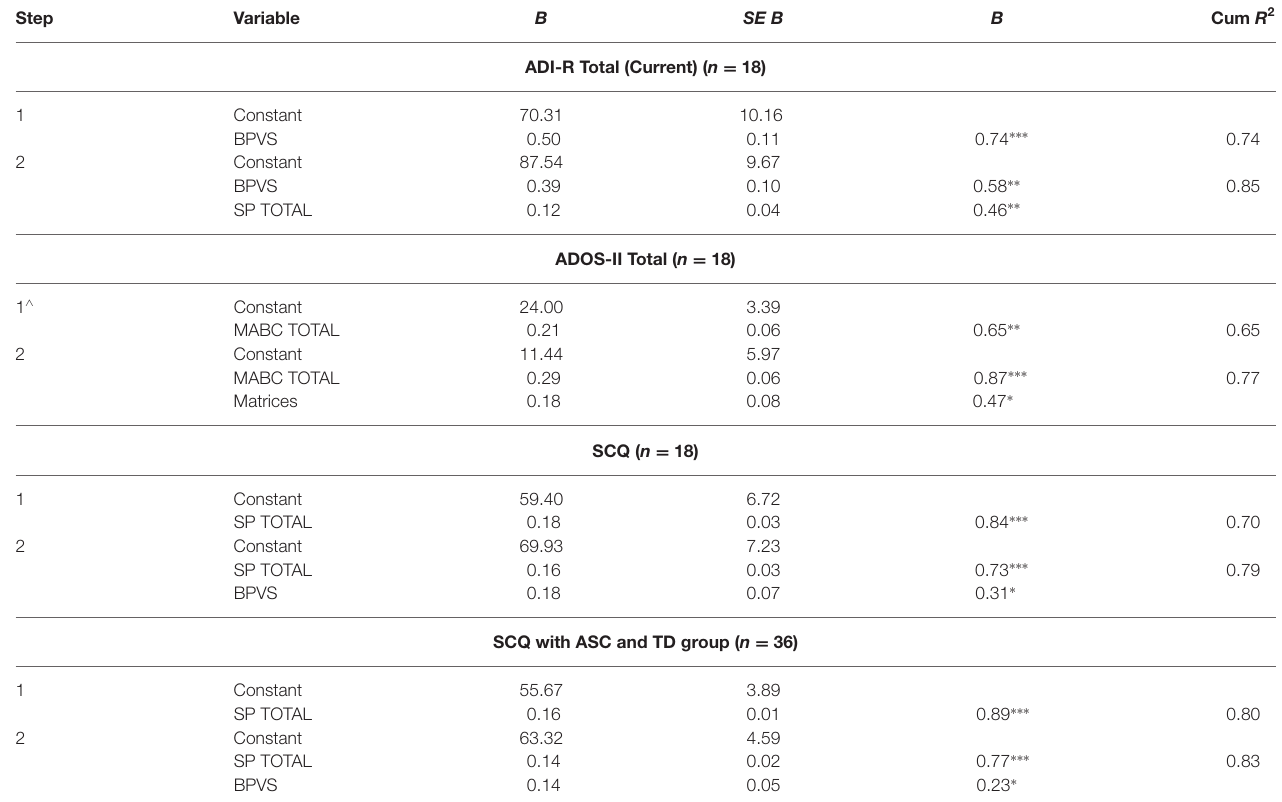
TABLE 4 | Stepwise multiple regressions for autism symptom measures in ASC